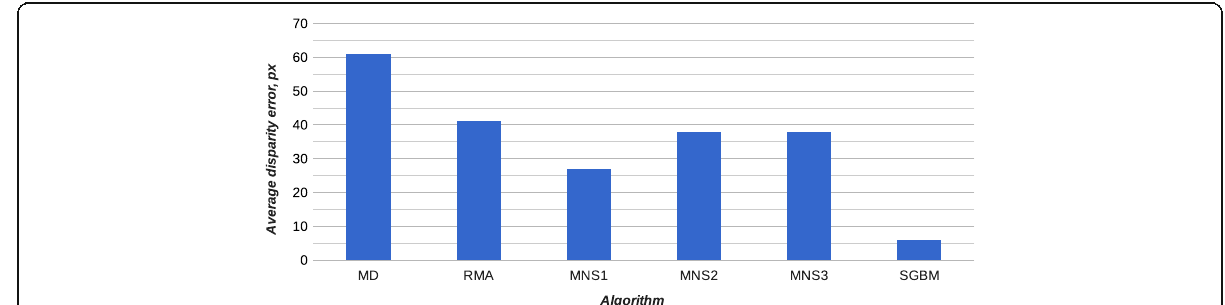
Fig. 11 The average disparity error of bad pixels. Evaluation performed on Q resolution training set